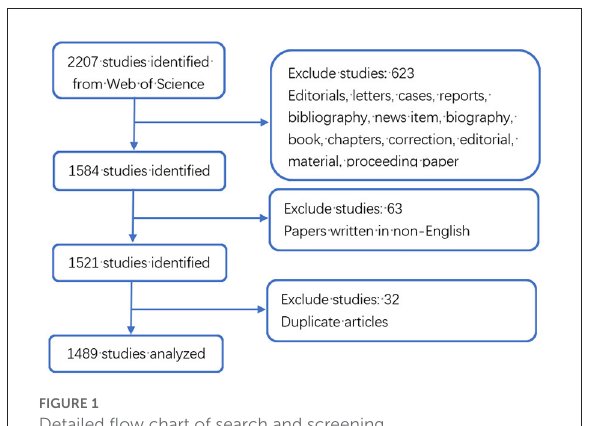
FIGURE1 Detailed flow chart of search and